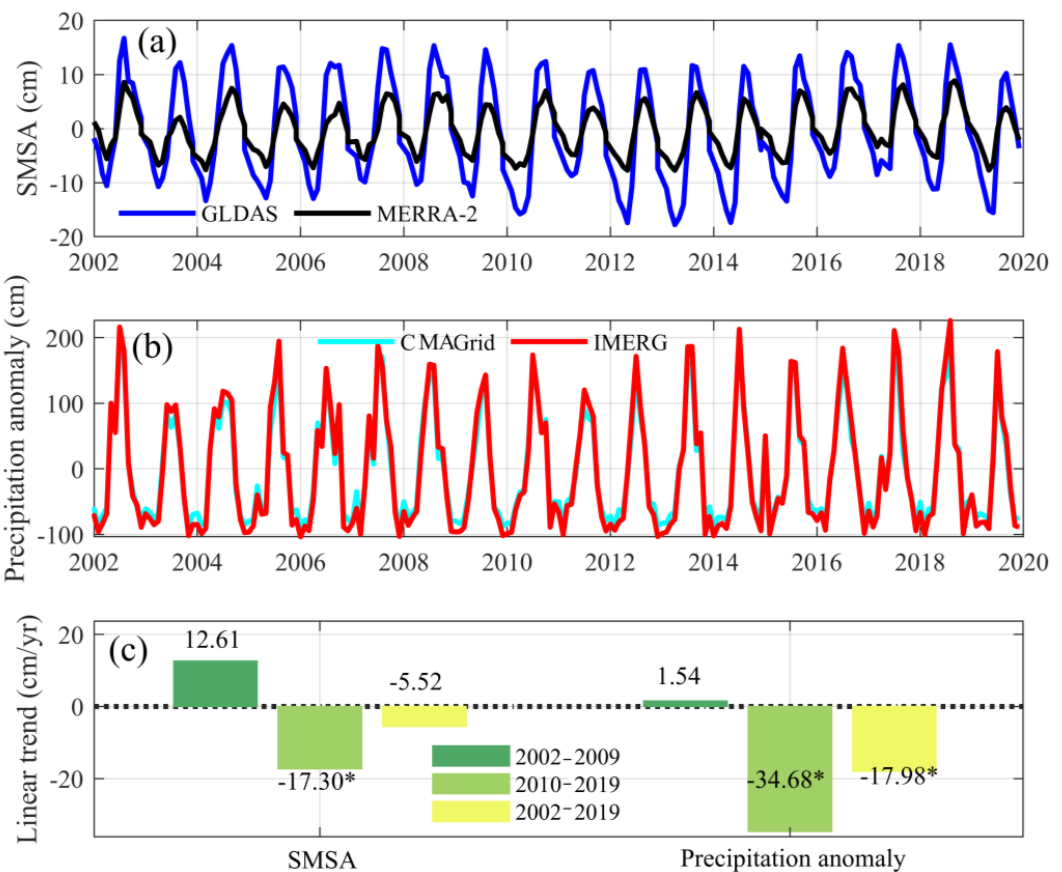
Figure 7. ( a ) Time series of monthly soil moisture storage anomaly (SMSA) derived from GLDAS and MERRA-2 products, ( b ) time series of monthly precipitation derived from CMAGrid and IMERG, ( c ) linear trends of SMSA and precipitation anomaly in the study region. Asterisk (*) refers to statistically significant values ( p -value < 0.05).